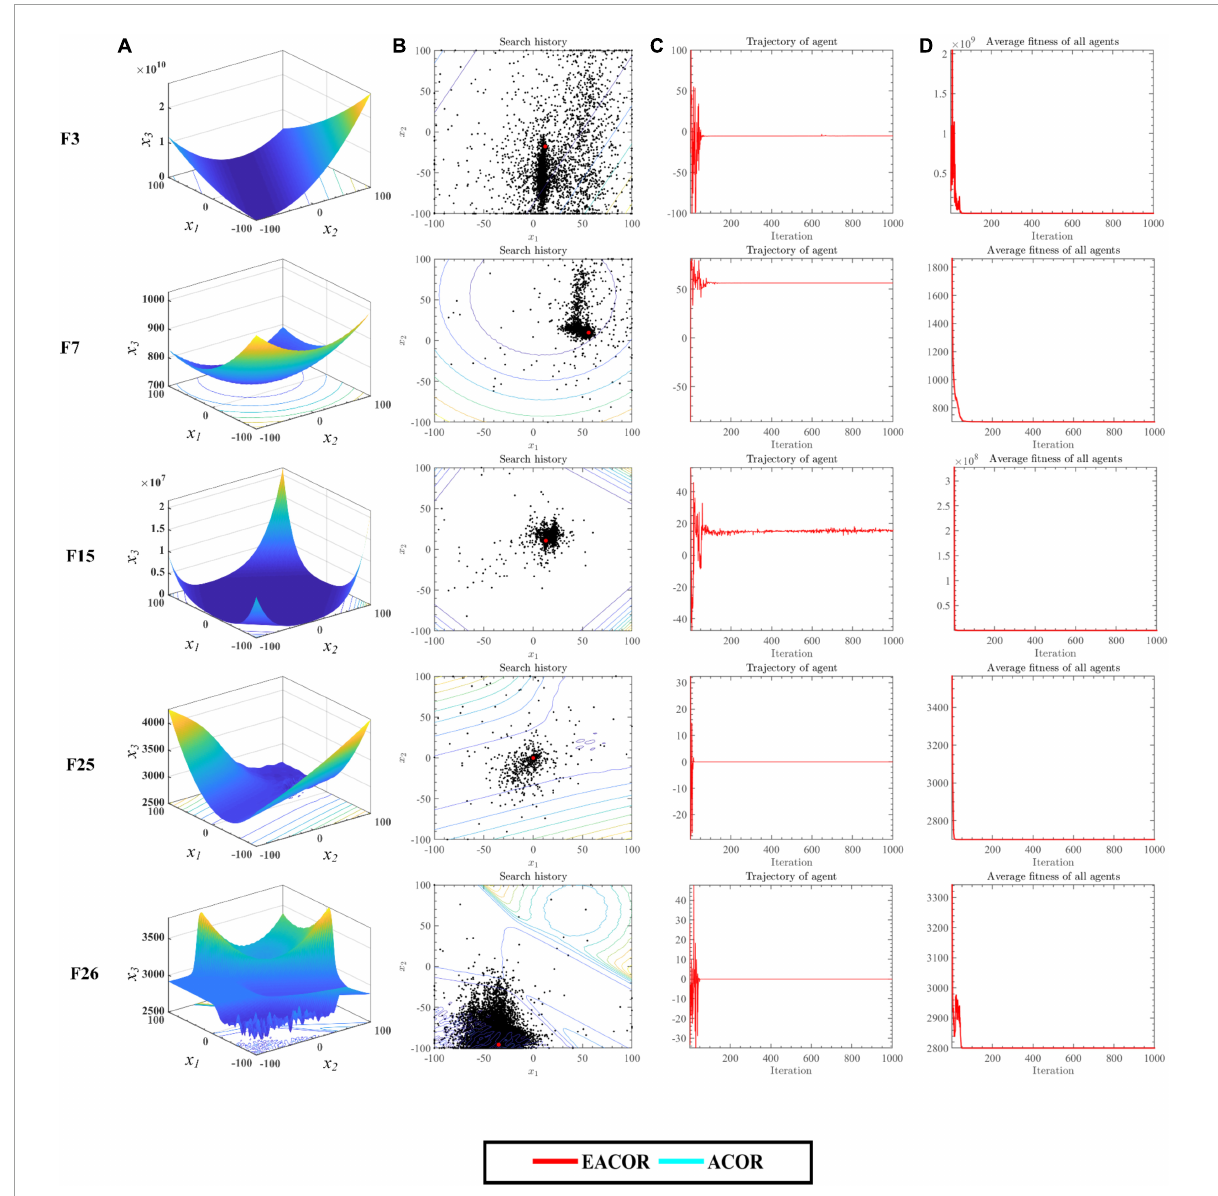
algorithm’s exploration of the search space and improves